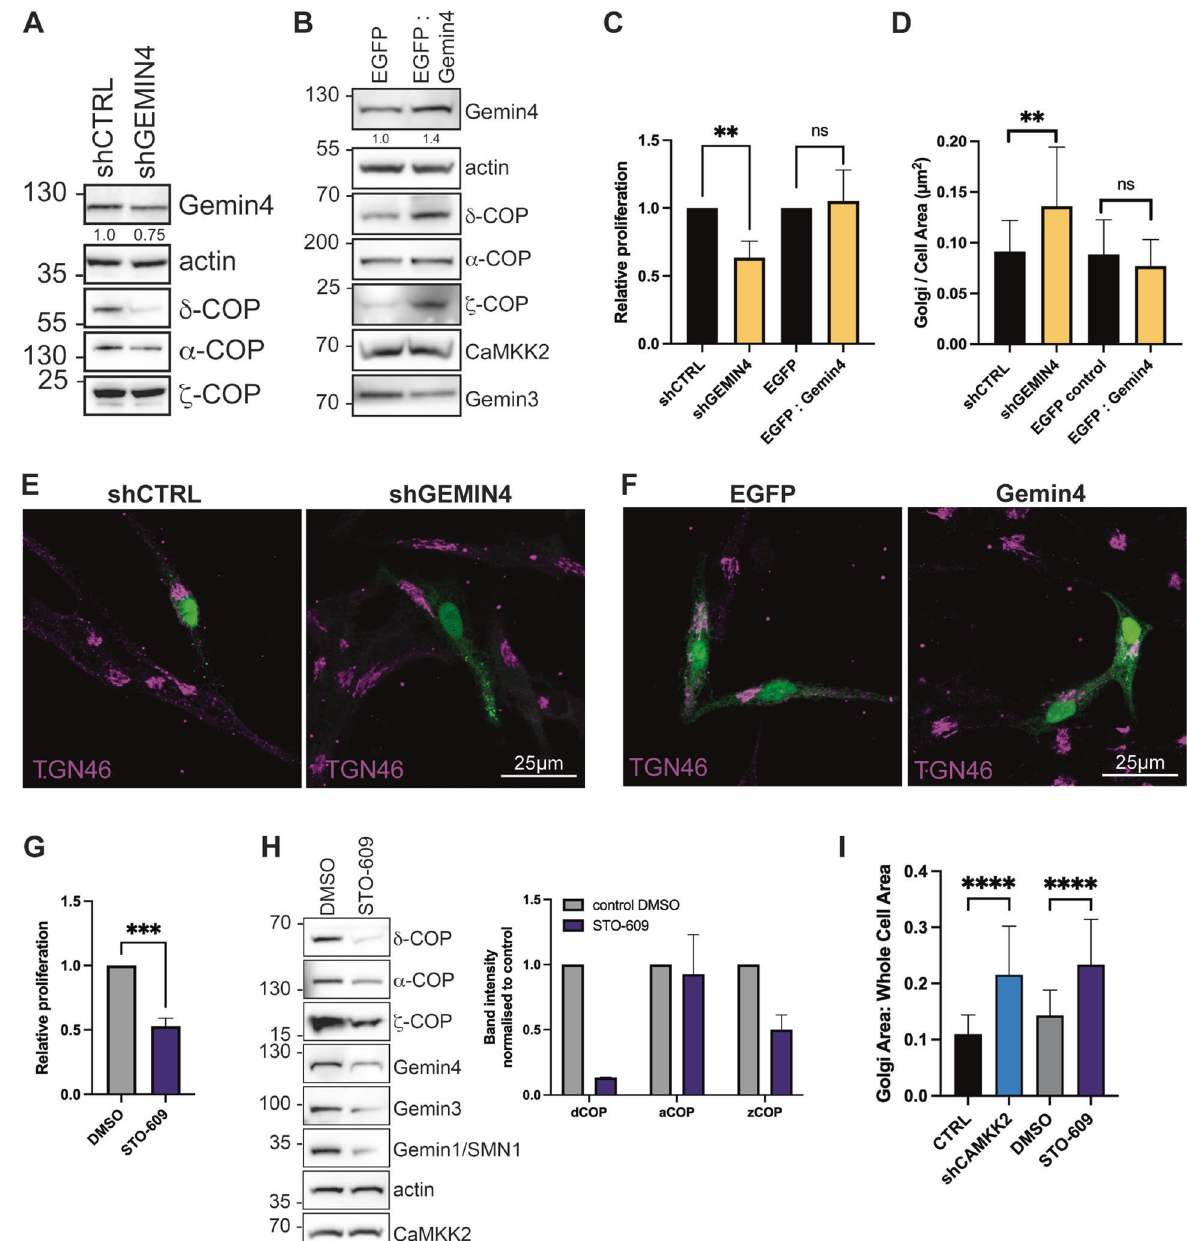
Fig. 4 Gemin4 regulates COPI subunit expression, proliferation and Golgi morphology. A LNCaP cells were treated with shRNA targeting GEMIN4 for 48 h. Protein expression levels were assessed by western blotting. Actin was used as loading control. B LNCaP cells were transiently transfected with a Gemin4 expression construct and protein expression levels were assessed by western blotting. Actin was used as a loading control. C Cell proliferation in Gemin4 knockdown and overexpressing LNCaP cells was compared to the respective control: control shRNA and EGFP. Cells were grown for 48 h in media supplemented with 10% charcoal-stripped serum. Mean ± SD, N = 3 independent experiments with 3 technical repeats; ** P = 0.0064, ns = 0.72. D Quanti fi cation of Golgi area (TGN46-postive) from confocal images (shown in E , F ) in Gemin4 knockdown and overexpressing LNCaP cells. Mean ± SD. Twenty-two knockdown cells and 20 overexpressing cells were analysed per group. ** P = 0.0030, ns = 0.24. E , F Images showing maximum intensity z -projections of confocal images of LNCaP cells transiently expressing EGFP-tagged shRNA or a Gemin4 expression constructs. Cell were stained with a TGN46 antibody (magenta). Scale bar, 25 µm. G Bar graph showing proliferation of LNCaP cells treated with 25 µM STO-609 for 120 h normalised to the DMSO control. Three independent experiments with three technical repeats were analysed. Mean ± SD; *** P = 0.0002. H LNCaP cells were treated with 25 µM STO-609 for 120 h. Protein expression of COPI components and Gemins were assessed by western blotting of 25 µg cell extracts separated on a SDS-PAGE gel. Actin was used as a loading control. Densitometry was performed on two experiments and normalised to control. Mean ± SD. I Bar graph showing the impact of 25 µM STO-609 treatment for 120 h in LNCaP cells on Golgi area (TGN46-positive) compared to CaMKK2 knockdown (shRNA2) cells. Mean ± SD. N = 31 cells; **** P <